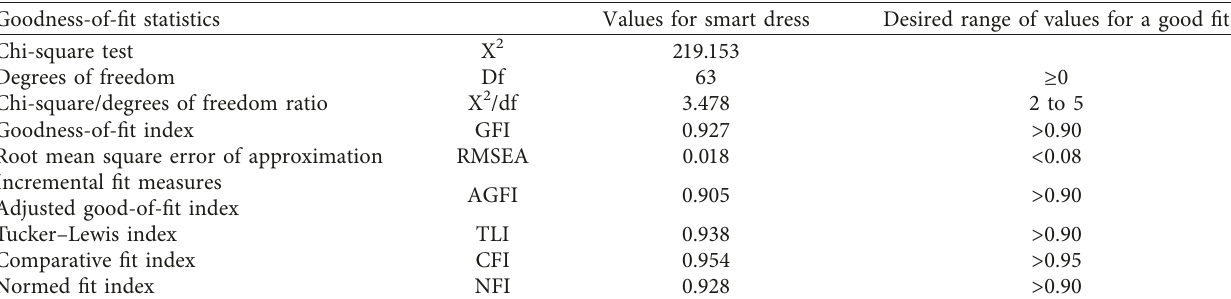
Table 3: Goodness-of-fit results of the